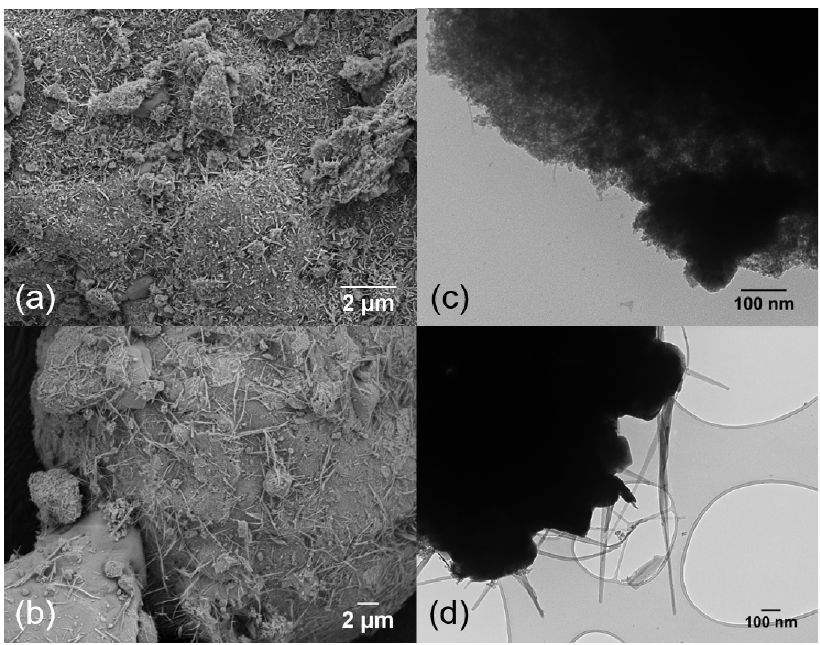
Figure 5. ( a ) SEM image and ( c ) TEM image of 1,3,12 RuFeK. ( b ) SEM image and ( d ) TEM images of 1,3,12 RuSrK.